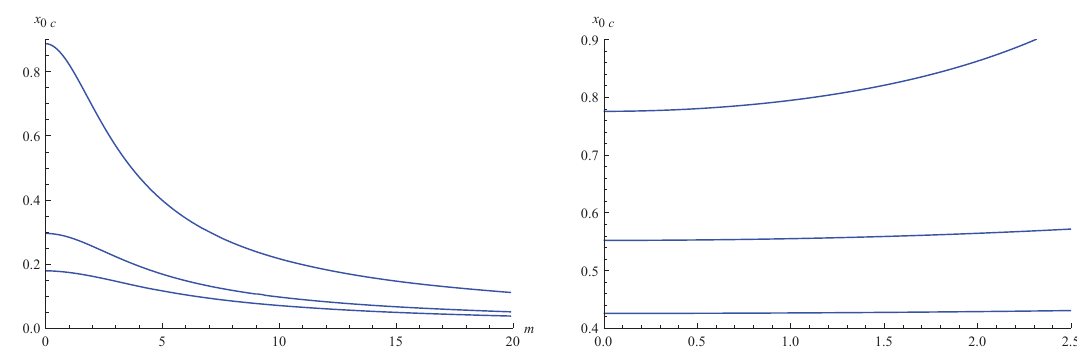
Figure 5 . Left: relation between the critical width x 0 c and graviton mass m by (cid:12)xing charge Q = 2. Curves from top to down correspond to r h increasing from 1 to 5 with steps 2, respectively. Right: relation between critical width x 0 c and the charge Q while (cid:12)xing the graviton mass m = 0 : 6. Curves from top to down correspond to r h increasing from 1 to 2 with steps 0.4,